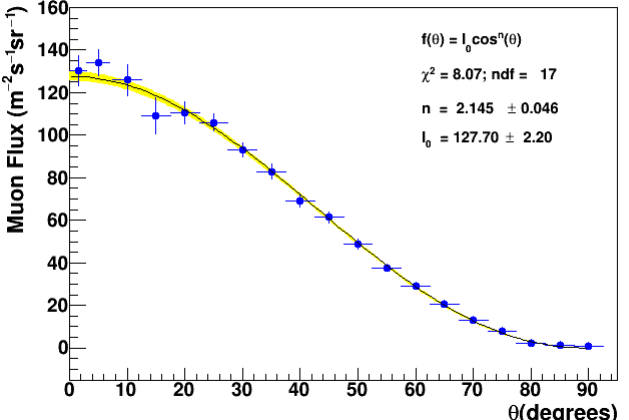
Figure 6. Fit of the measured muon flux distribution to a cos 2 θ function. The yellow band shown corresponds to the one sigma uncertainty.